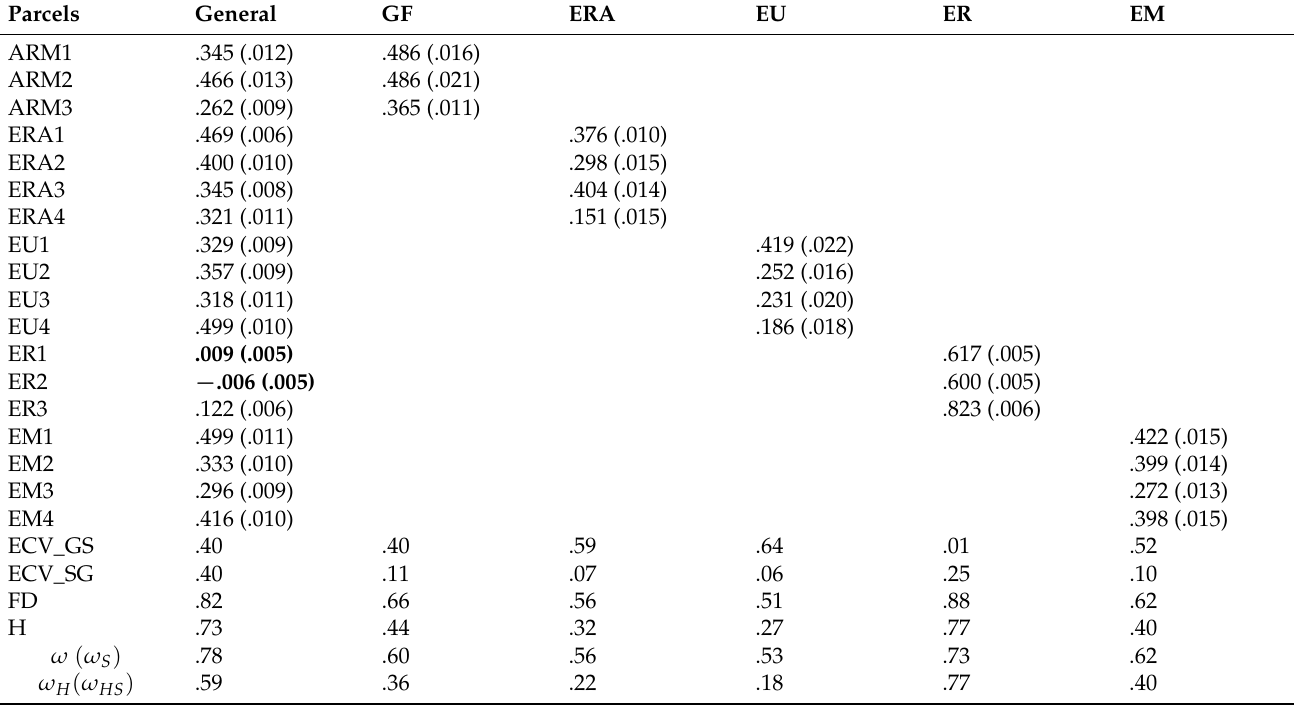
Table 4. Standardized Parameter Estimates (and Standard Error in Parentheses) from the Bifactor Model and Explained Common Variance (ECV), Factor Determinacy (FD), Construct Replicability (H), and Model-Based Reliability Indices.